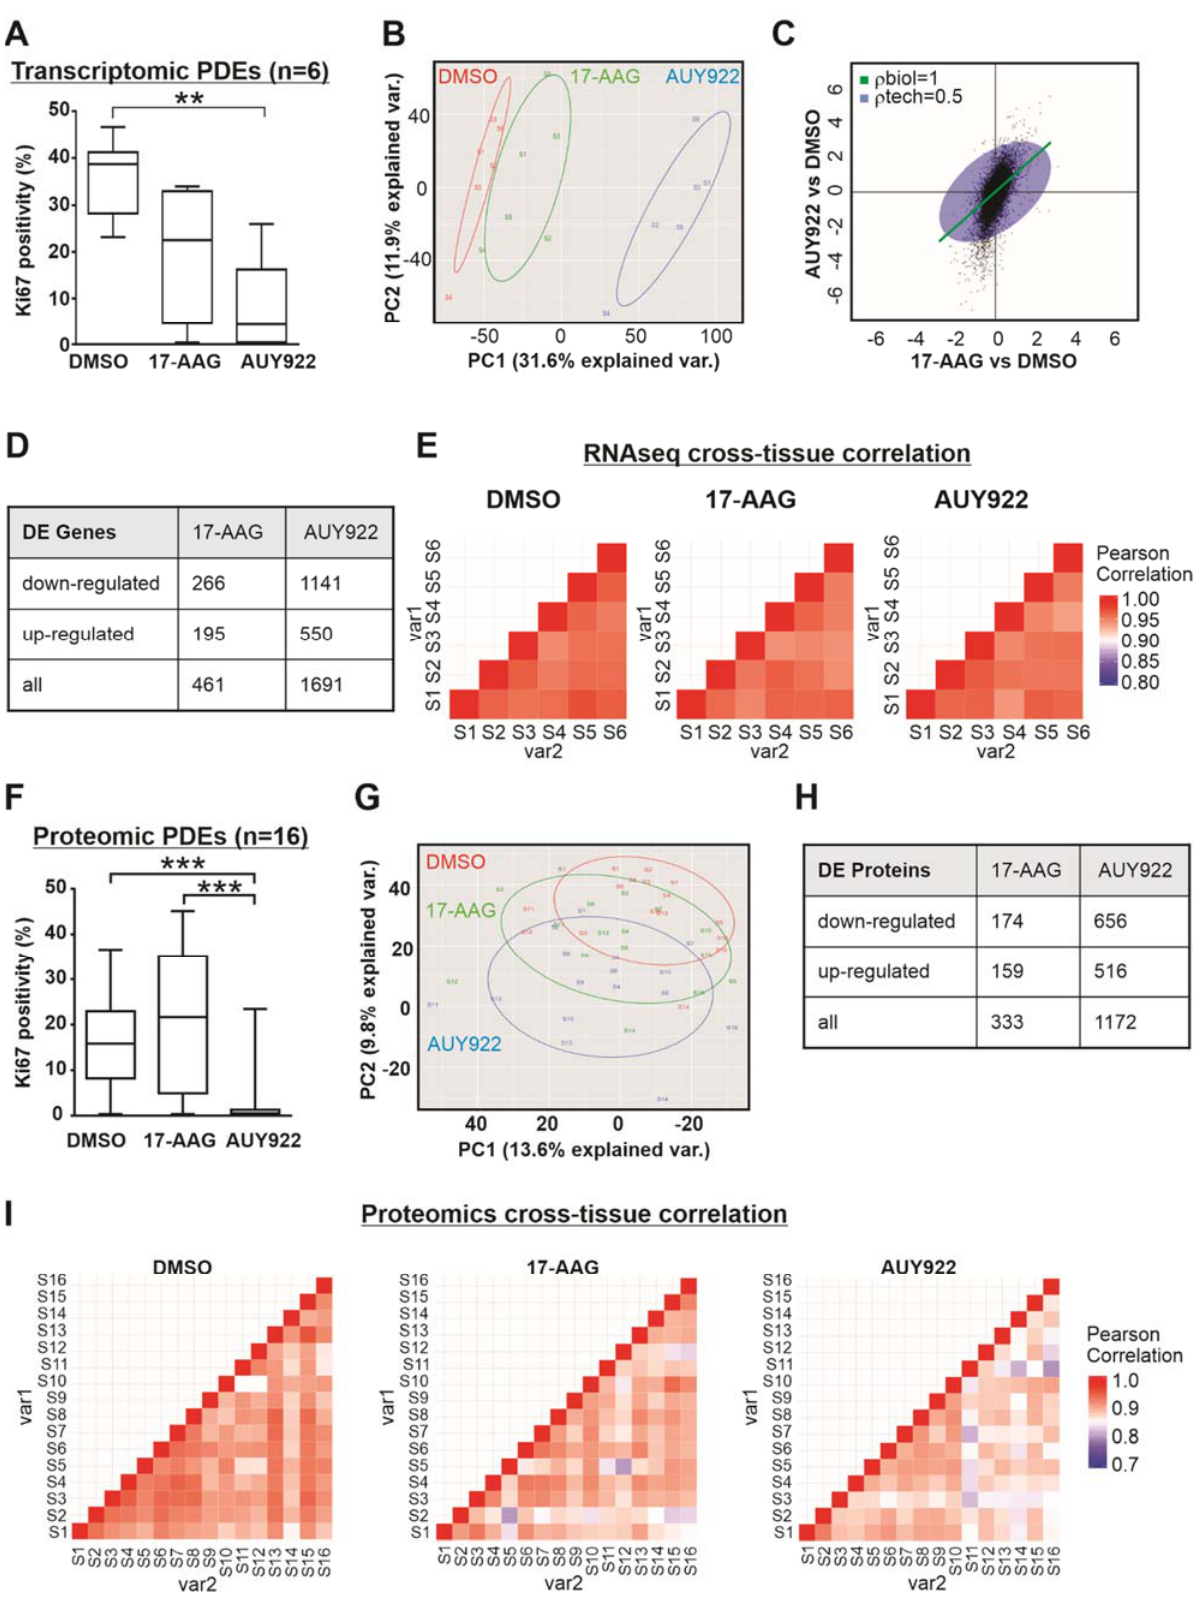
Figure 4. Transcriptomic and proteomic analysis of patient ‐ derived explants. ( A ) Box plot showing significant inhibition of proliferation (Ki67 immunostaining) in AUY922 treated prostate cancer PDEs used for RNAseq analysis ( n = 6). Box represents the median, 25th and 75th percentile values, and whiskers represent minimum and maximum values. ( B ) Principal component analysis (PCA)